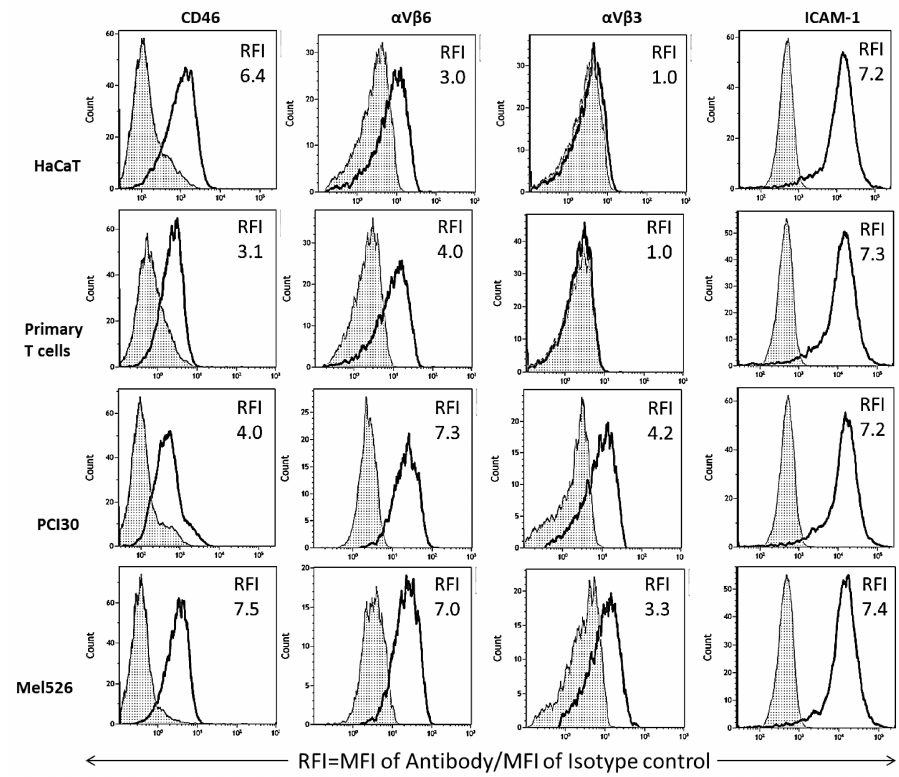
Figure 2. On-bead flow cytometry of exosome populations isolated from supernatants of 4 different cell lines, captured on streptavidin beads coated with biotinylated anti-CD63 mAbs and stained with the labeled detection Abs specific for CD46, α V β 6, α V β 3 and ICAM1 as described in Methods. Data are relative fluorescence intensity (RFI) values calculated as mean fluorescence intensity (MFI) of an experimental sample / MFI of an isotype control Ab. [White peaks = experimental samples; hatched peaks = isotope controls]. Note that exosomes produced by non-malignant cells (HaCaT and primary T cells) appear to differ from exosomes produced by malignant cells by the absence of α V β 3 and lower expression levels of α V β 6. Representative results are from 1 to 3 detection experiments performed with each exosome population.